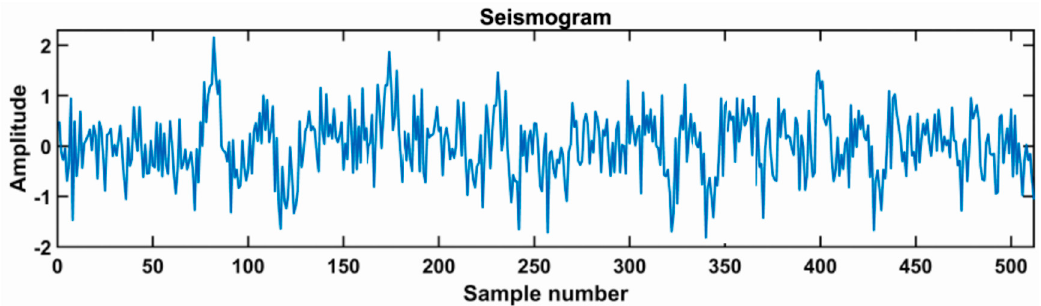
Figure 9. Synthetic seismogram contaminated by noise (SNR = − 4.55 dB).